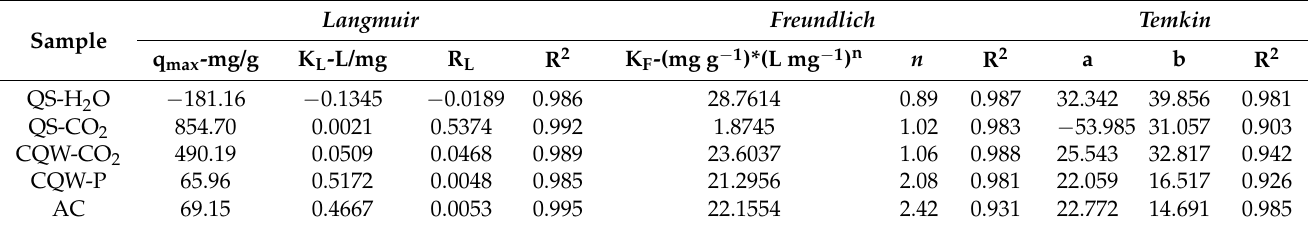
Table 5. Model parameters calculated for CV adsorption onto QS and CQW activated